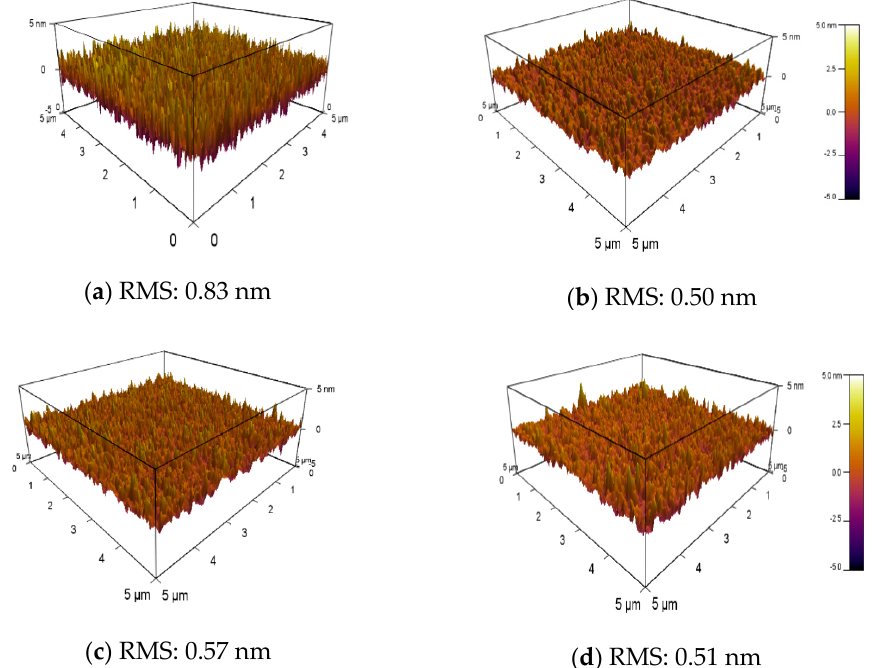
Figure 2. Atomic force microscope images of films grown with ( a ) N 2 0 sccm, ( b ) N 2 10 sccm, ( c ) N 2 20 sccm, and ( d ) N 2 50 sccm.